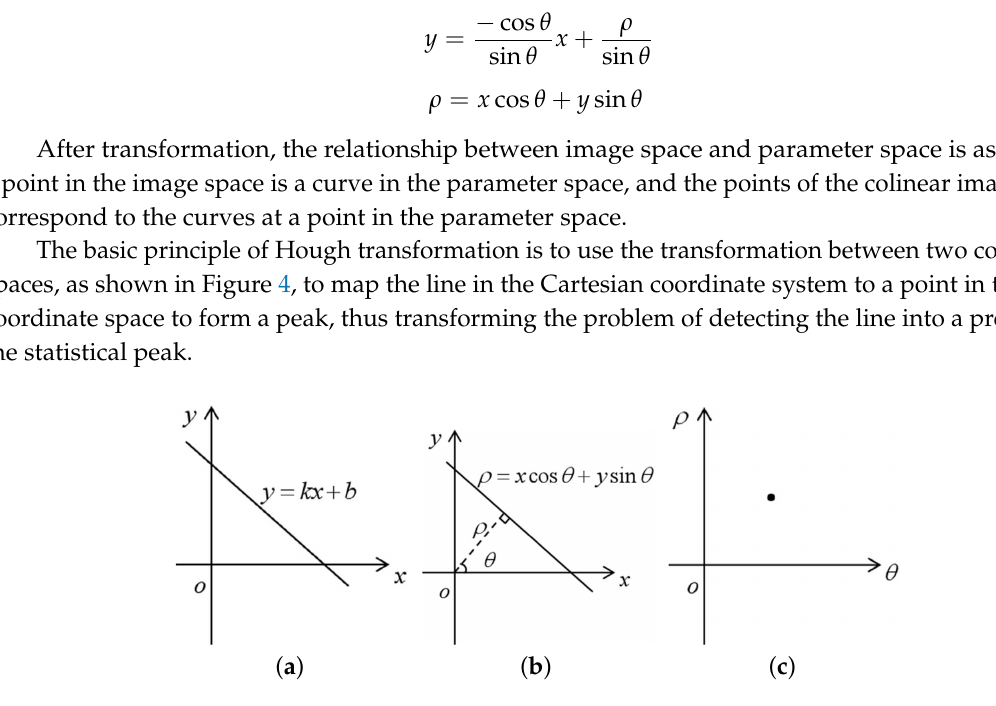
Figure 4. Diagram of coordinate system transformation: ( a ) the expression of line in image space, ( b ) the expression of line in image space, ( c ) the expression of line in parameter space. These three expressions are